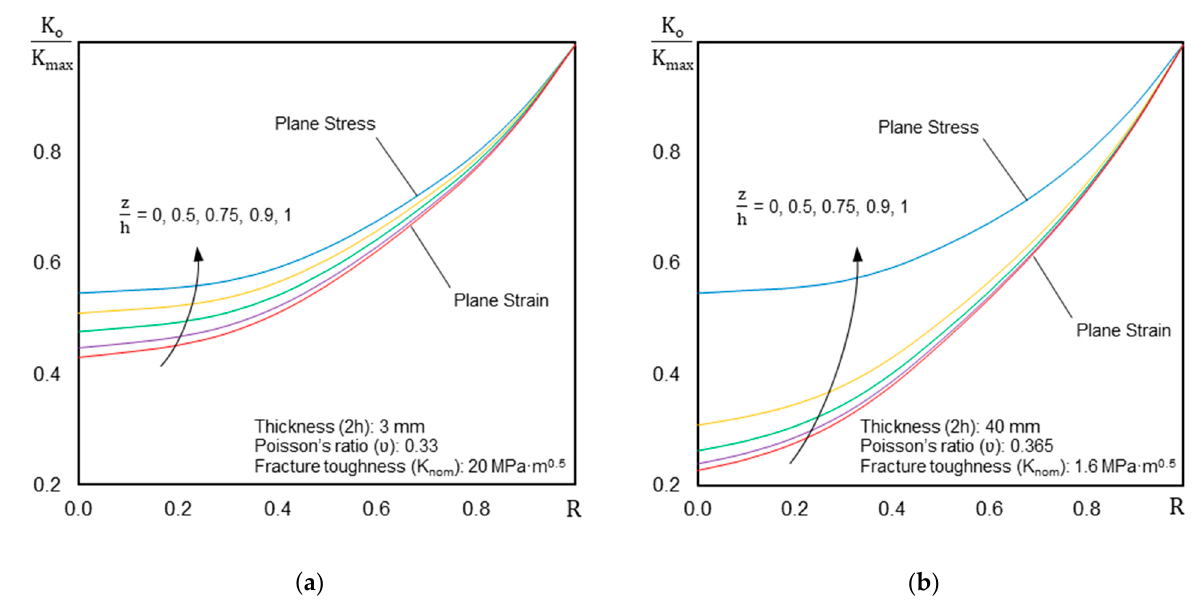
( b ) Figure 7. A comparison between the predicated crack shapes and experimental data for the specimens composed of: ( a ) 6082-T6 aluminium alloy and ( b ) polymethyl methacrylate. This methodology can also be applied to conduct parametric studies associated with the main variables affecting the fatigue crack growth of through-the-thickness cracks. A subject that can be analysed with the developed approach is the effect of the stress ratio on crack closure values. Figure 8 plots the ratio of the opening stress intensity factor ( K o )